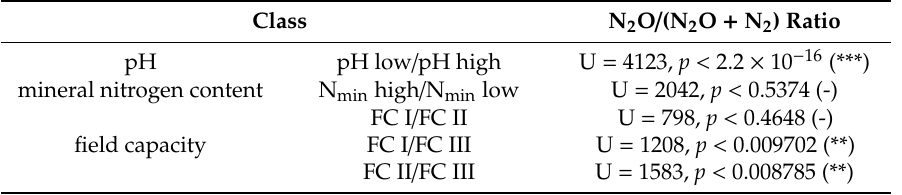
Table 2. Comparison of the denitrification product ratios (N 2 O / (N 2 O + N 2 )) for the rewetting days 0 to 13 of all subdivided classes (pH class (n = 66), Nmin class (n = 66), FC class (n = 66)). Method used: Mann–Whitney U-Test (U). (significance levels p > 0.05 (-) = not significant, p ≤ 0.05 (*) = significant, p ≤ 0.01 (**) = very significant, p ≤ 0.001 (***) = highly significant result).